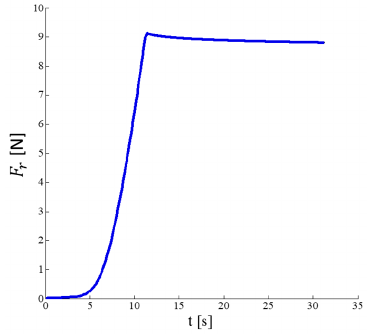
Figure 3. Evolution over time of the force applied on the sensor by using the traction/compression testing machine during the three repetitions. The depth of the curve represents the mean value of the force applied during the three trials ± the standard deviation.